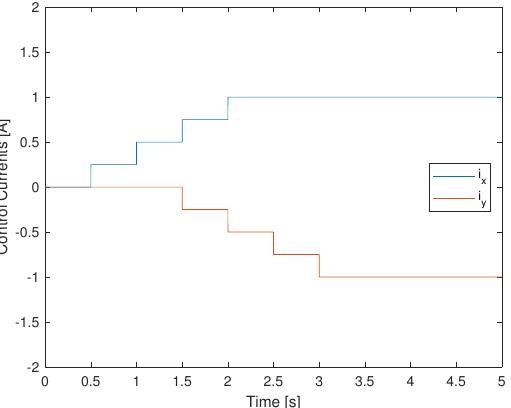
Figure 17. Profile of the control current